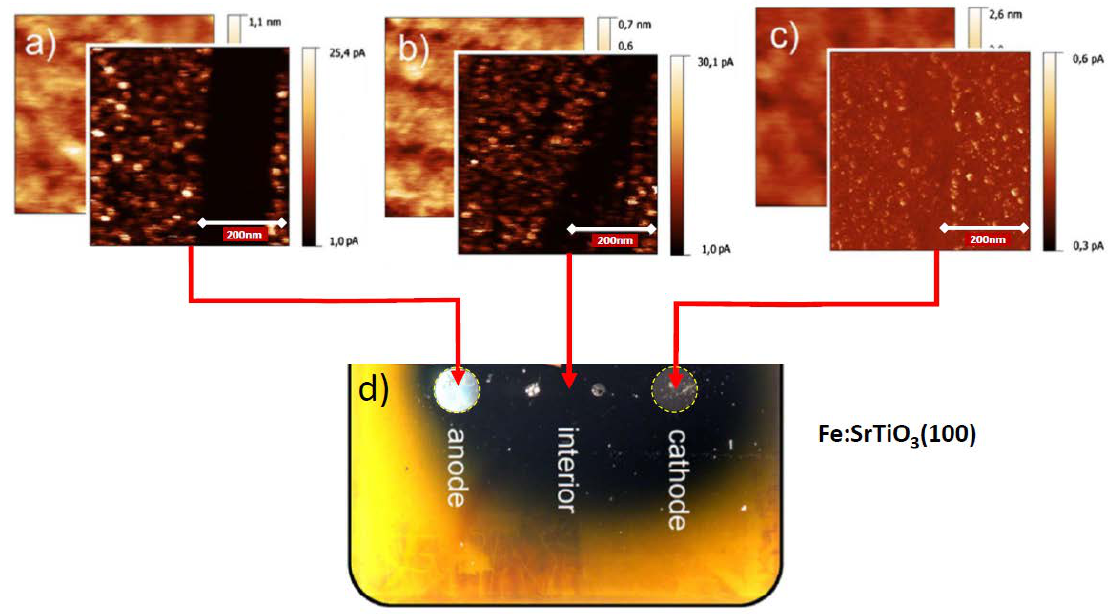
Figure 60. LCAFM measurements of a Fe:SrTiO 3 (100) crystal after electro-reduction. The local topography and corresponding local conductivity maps for: ( a ) cathode; ( b ) interior; and ( c ) anode are presented. Optical image of the sample after electroreduction and reoxidation in ambient atmosphere ( d ). Adapted from [58].